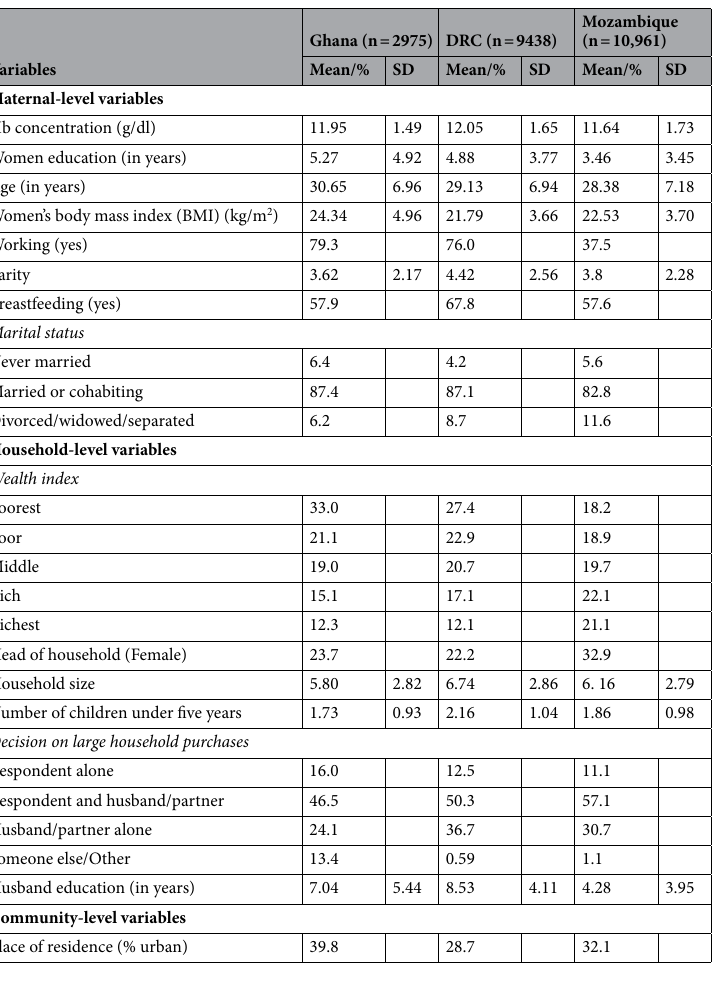
Table 1. Characteristics of the socio-demographic variables of the three countries. SDs are reported only for continuous variables. SD standard deviation, Hb